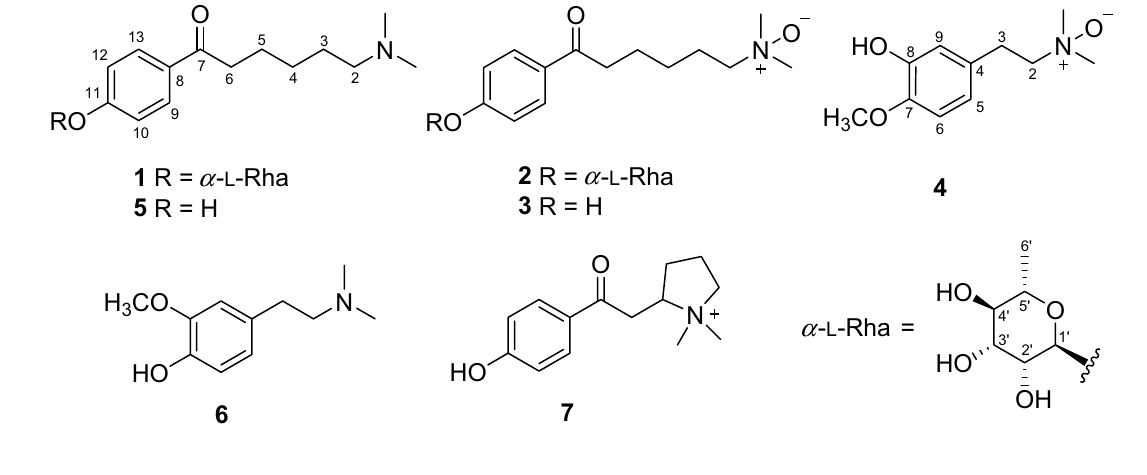
Fig. 1 Structures of compounds 1 – 7 Table 1 1 H (400 MHz) and 13 C (150 MHz) NMR data for compounds 1 – 4 (in methanol- d